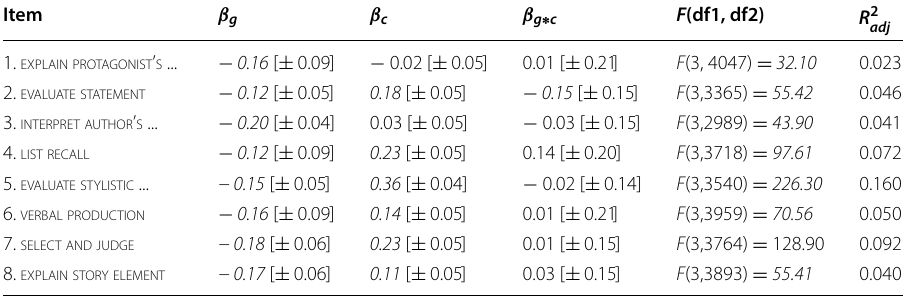
Table 3 Proposition Entity Count (PEC) by gender and response